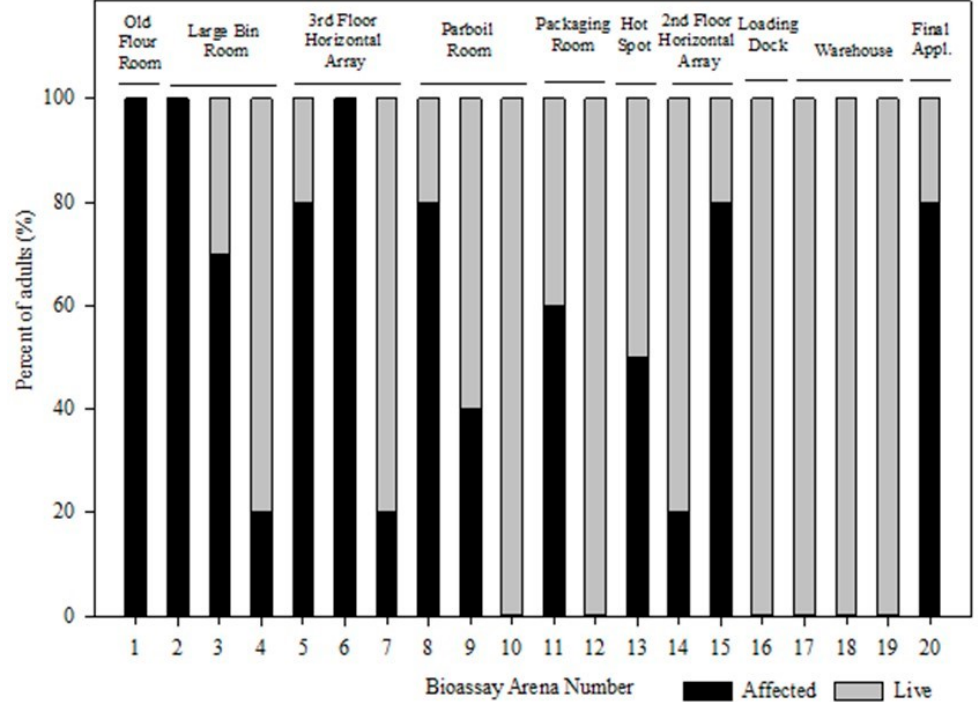
Figure 3. The percent of live vs. affected T. confusum adults after initial exposure to aerosol applications at each bioassay arena location.